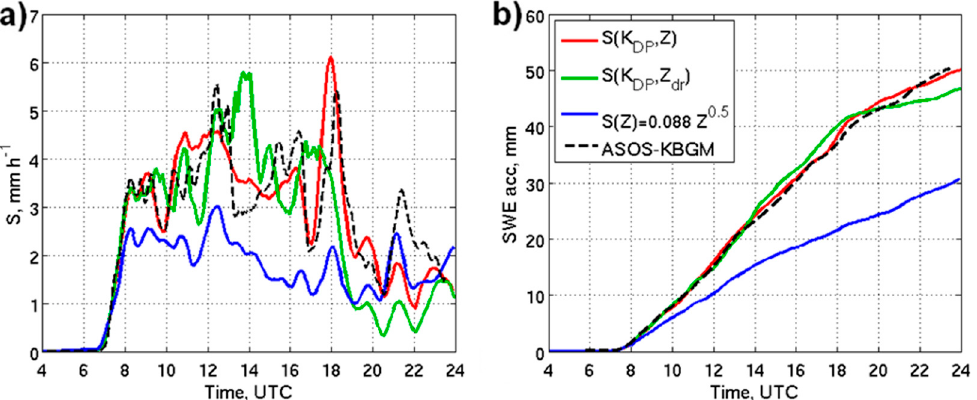
Figure 18. Instantaneous snowfall rates (mm h − 1 ) ( a ) from the KBGM ASOS extinction coefficient estimates (black dashed curve; ground), and radar RD-QVP estimates from S ( K DP , Z ) (red line; 0.5 km AGL), S ( K DP , Z dr ) (green line; 0.5 km AGL), S ( Z ) (blue line; 0.05 km AGL); respective SWE accumulations (mm) ( b ) from; 14 March